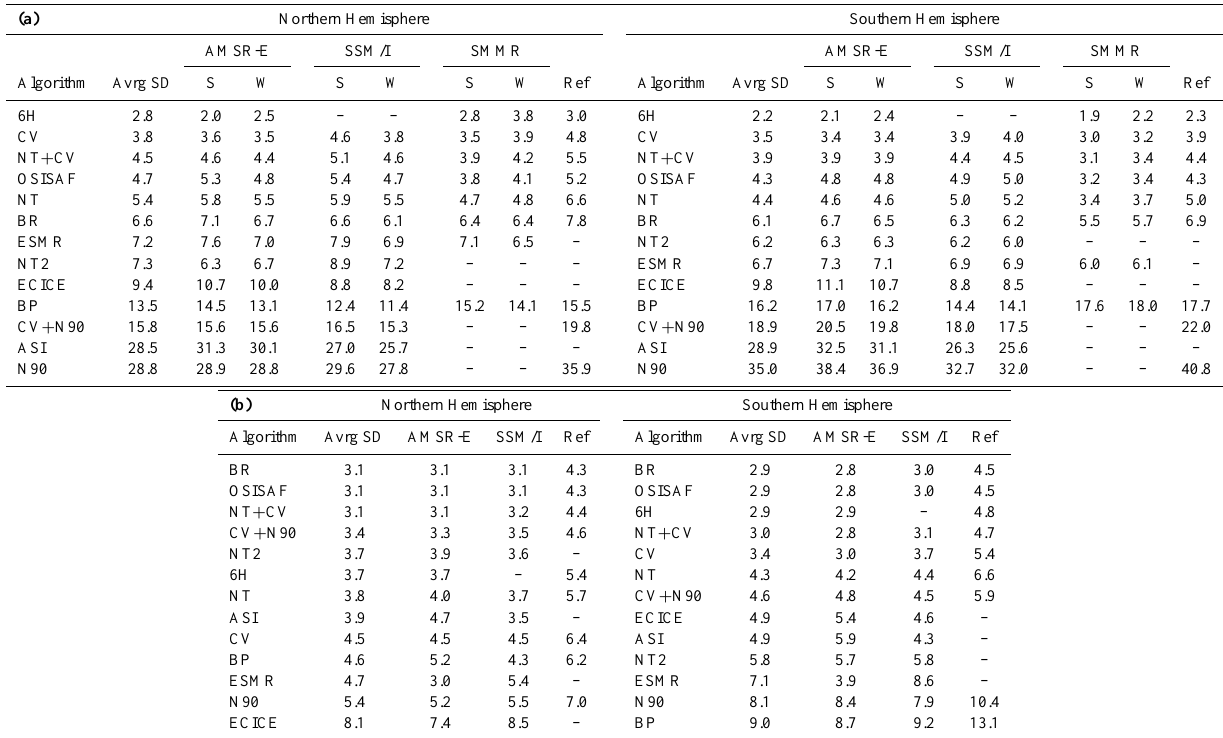
Table 2. (a) Sea ice concentration (SIC) standard deviation (SD) (in %). Low SIC: 15% (0% for SMMR), winter (W) and summer (S).